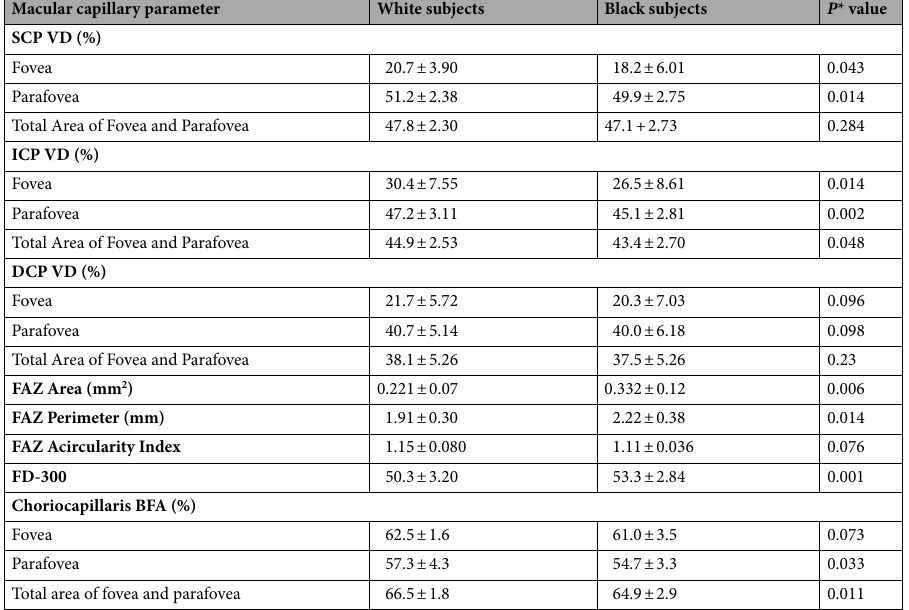
Table 3. Macular capillary parameters measured using optical coherence tomography angiography in white and black subjects. Data provided show the results of a mixed effects regression correlating race and macular capillary parameters, adjusting for 2 eyes of the same patient and axial length. Data are provided as mean ± standard deviation. Fovea refers to the central 1-mm diameter circular area. Parafovea refers to the 3-mm diameter area excluding the central 1-mm diameter. P * value calculated controlling for 2 eyes of the same patient, and axial length. VD = vessel density. SCP = superficial capillary plexus. ICP = intermediate capillary plexus. DCP = deep capillary plexus. FAZ = foveal avascular zone. FD-300 = capillary density in a 300 μm wide region around the FAZ. BFA = blood flow